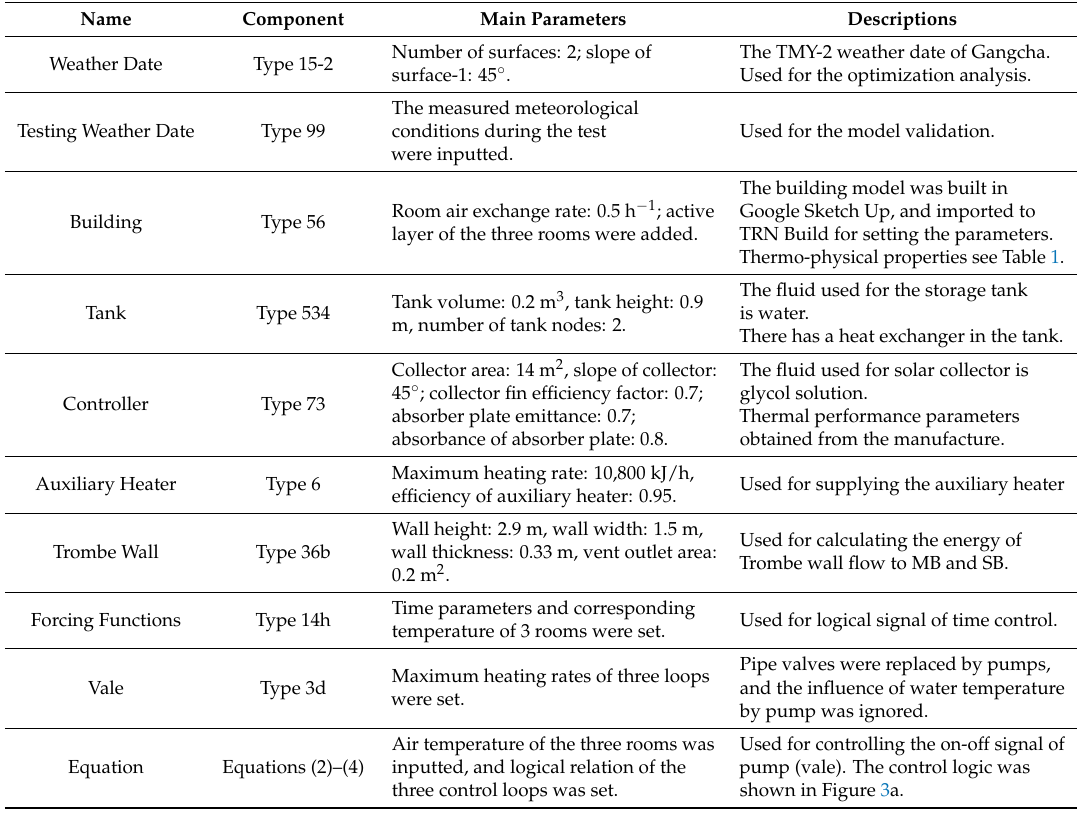
Table 4. Main components and parameters of TRNSYS